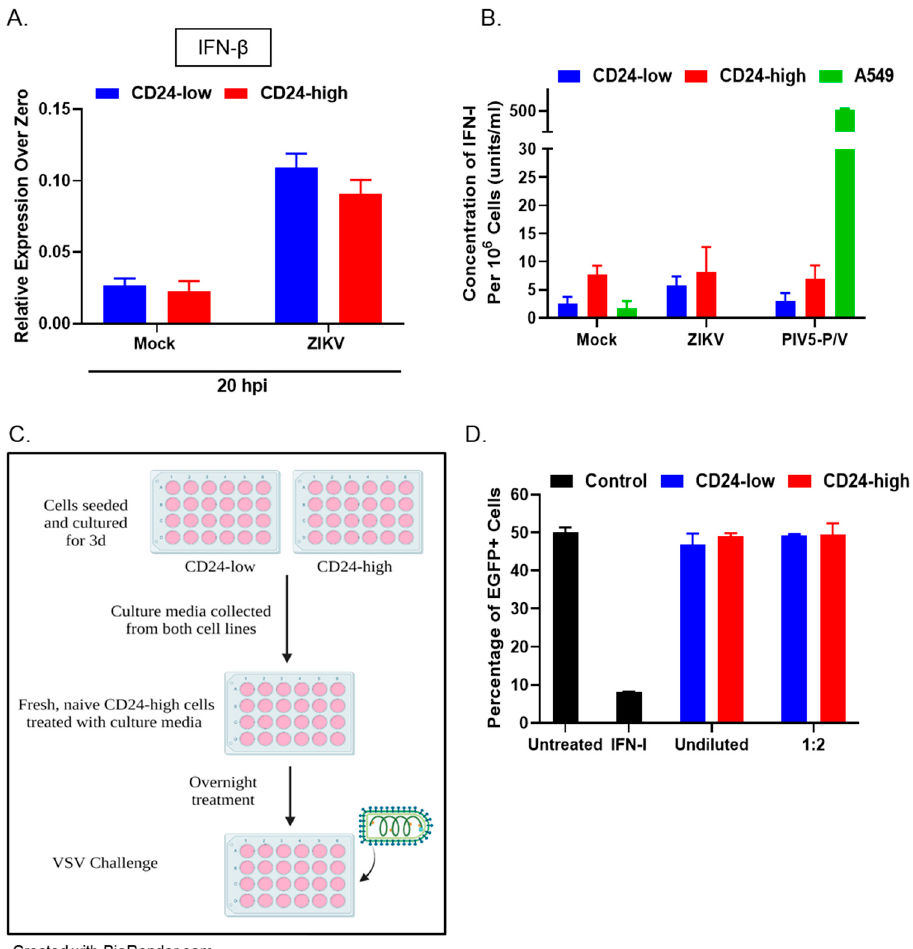
Figure 7. Soluble factors do not differentiate between the sensitivity of CD24-low and CD24-high cells to virus infection. ( A ) Cultures of CD24-low and -high cells were either mock-infected or ZIKV- infected at MOI of 5, and total cellular RNA was isolated at 20 hpi. Levels of IFN- β were evaluated at 20 hpi and are expressed as a relative expression over time zero (basal levels). ( B ) CD24-low and -high cells were either mock-infected or infected with ZIKV for 18 h. A549 cells that were mock-infected or infected with PIV5-P/V mutant at MOI of 5 were used as negative and positive controls for IFN-I production, respectively (green bars). The levels of IFN-I in culture media were quantified using a biological assay with HEK-Blue™ IFN- α / β cells as an indicator cell line (as described in Materials and Methods). Data are a representation of two separate experiments. ( C , D ) Media were collected from uninfected CD24-low and -high cells and either left undiluted or diluted 1:2 to treat naïve CD24-high cells for 16 h. As negative and positive controls, CD24-high cells were left untreated or treated with 100 u/mL IFN-I, respectively (black bars). Treated CD24-high cells were then infected with VSV-EGFP at MOI of 5, and at ~6 hpi, the percentage of EGFP+ cells was determined by flow cytometry. Values are the mean of three samples.